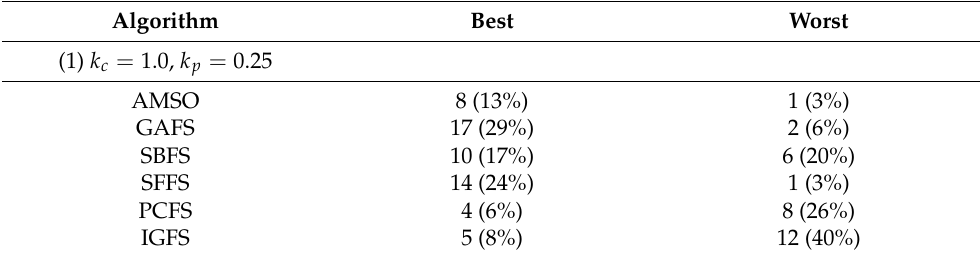
Figure 3. Box plot of algorithm ranks. Table 10. Best and worst algorithm counts.